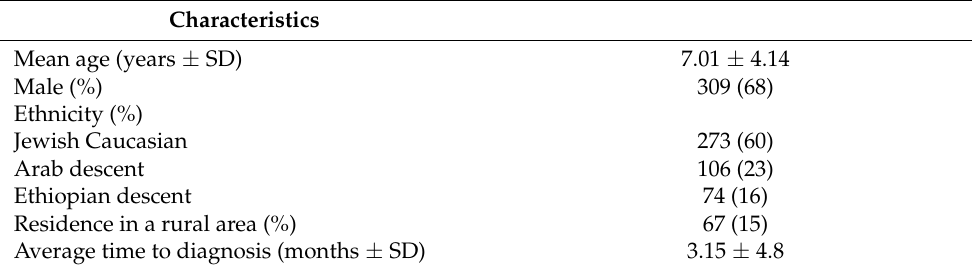
Table 1. Demographic characteristics of study population.